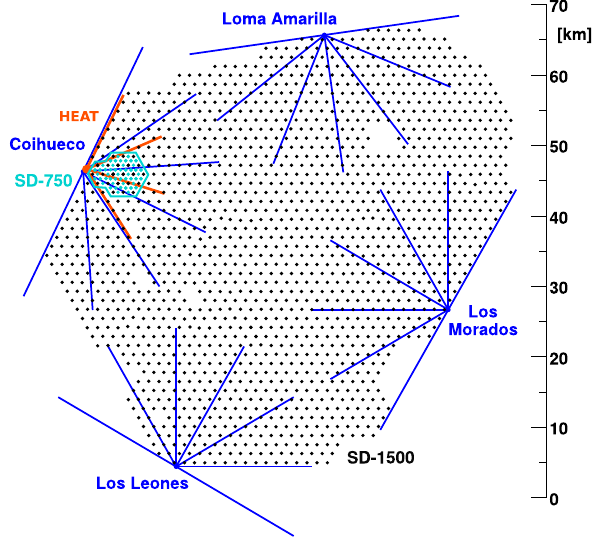
Fig. 1 The layout of the SD and FD of the Pierre Auger Observatory are shown above. The respective fields of view of the five FD sites are shown in blue and orange. The 1600 SD locations which make up the SD-1500 are shown in black while the stations which belong only to the SD-750 and the boarder of this sub-array are highlighted in